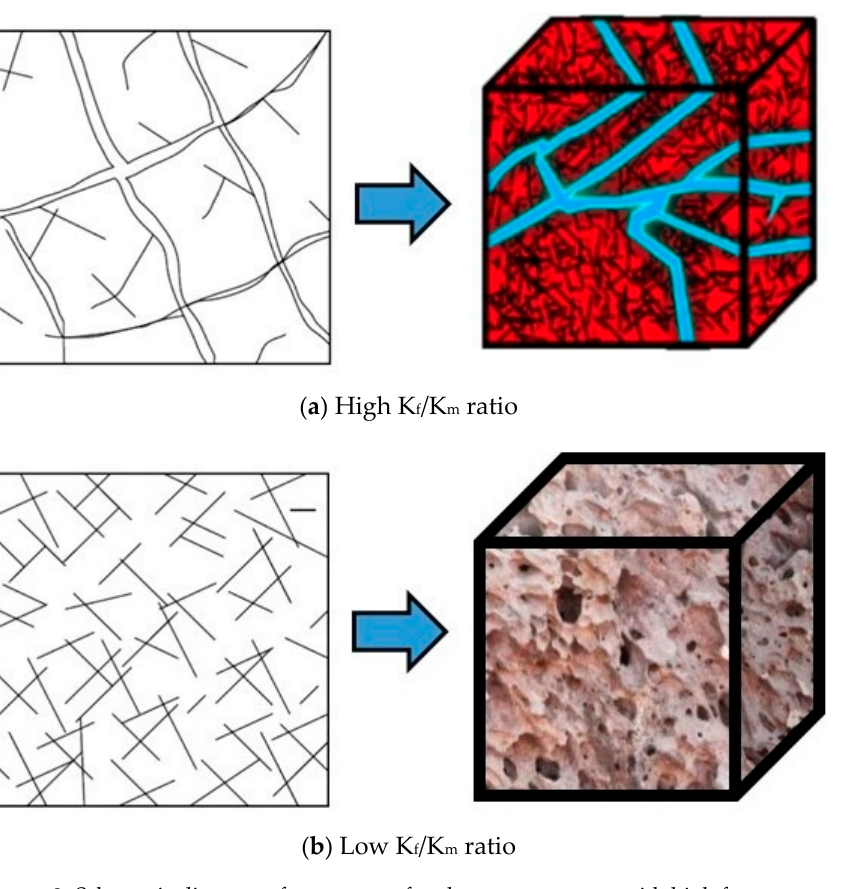
Figure 8. Schematic diagram of two types of rock mass structures with high fracture network den- sity (( a ) high K f /K m ratio and ( b ) low K f /K m ratio). (( a ) high K f /K m ratio and ( b ) low K f /K m